Question: Condense the content of this figure into a single sentence.
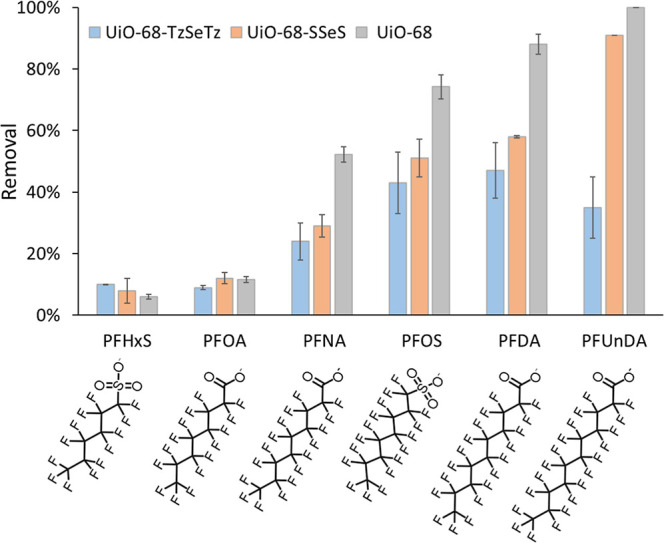
Answer: PFAS percentage removal from a tap water solution 0.1–3 μg/L in each PFAS by UiO-68-TzSeTz (blue) compared to UiO-68-SSeS (orange) and UiO-68 (gray).